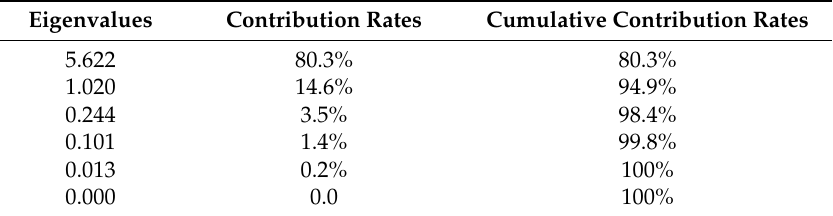
Table 2. The Contribution rates of The Eigenvalues.